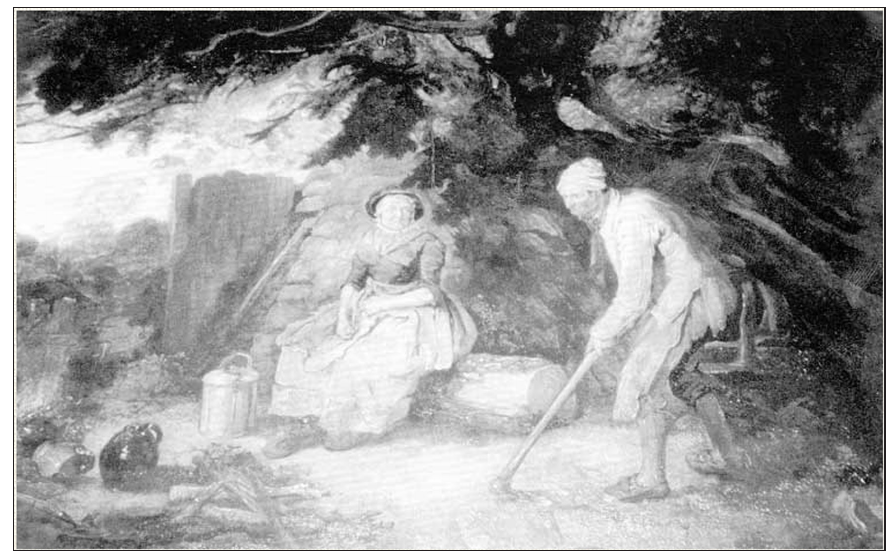
Fig . 3 : James Ward, Portrait of Luke and Betty Kenny, 1814. Image taken from ‘Crich Parish […] History of the Kenyon Family’, which acknowledges the help of Peter Kenyon-Smith <http://www. crichparish.co.uk/webpages/kenyonhistory.html> [accessed 23 February